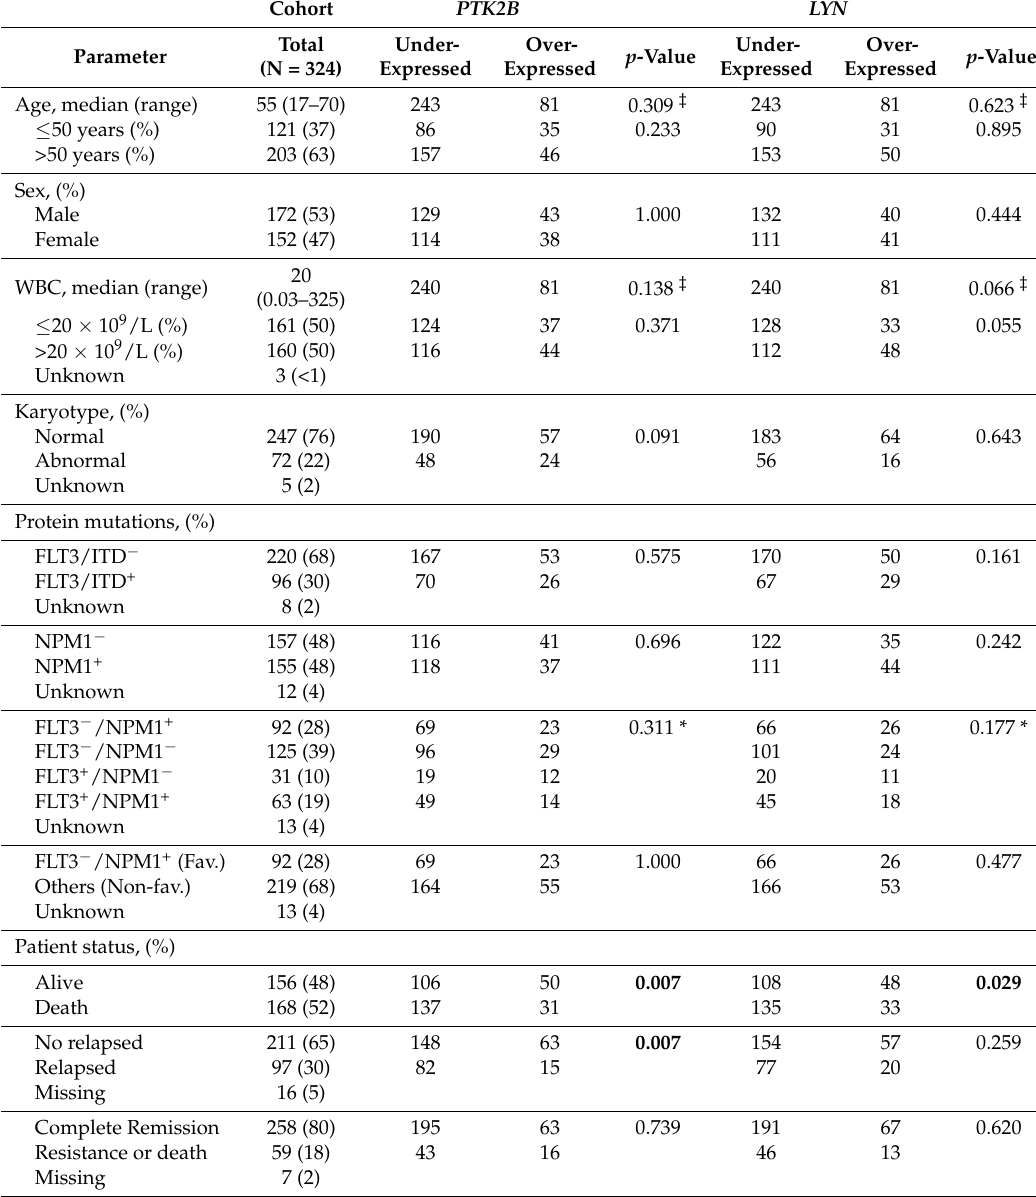
Table 3. Association between PTK2B or LYN expression level and the main clinical and molecular characteristics of the cytogenetic IR-AML patient